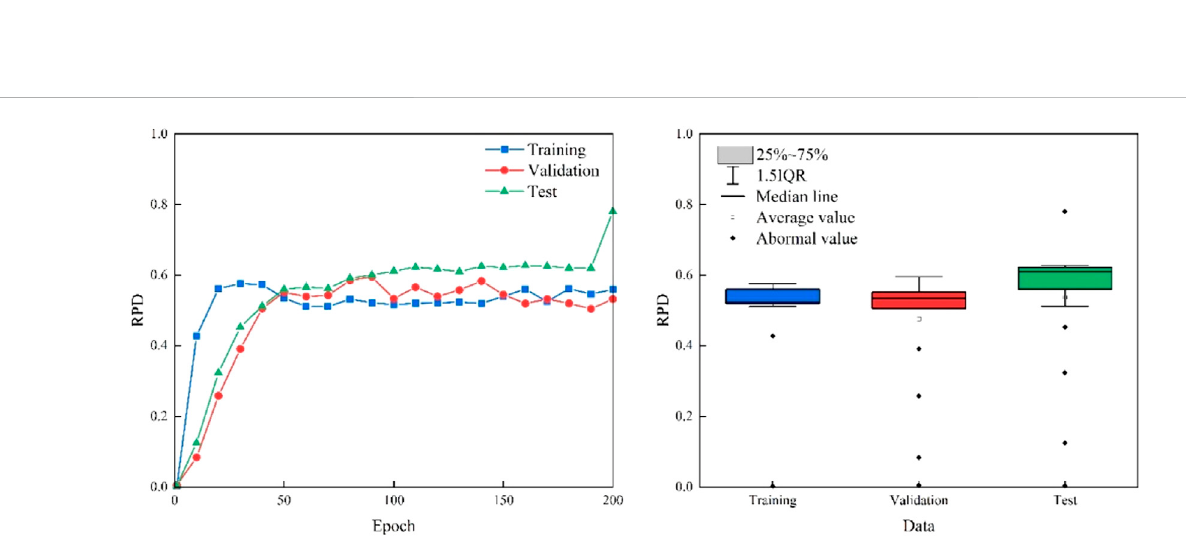
FIGURE 7 The ratio of prediction to deviation of the learning system at the training, validation, and testing stages with 200 epochs.